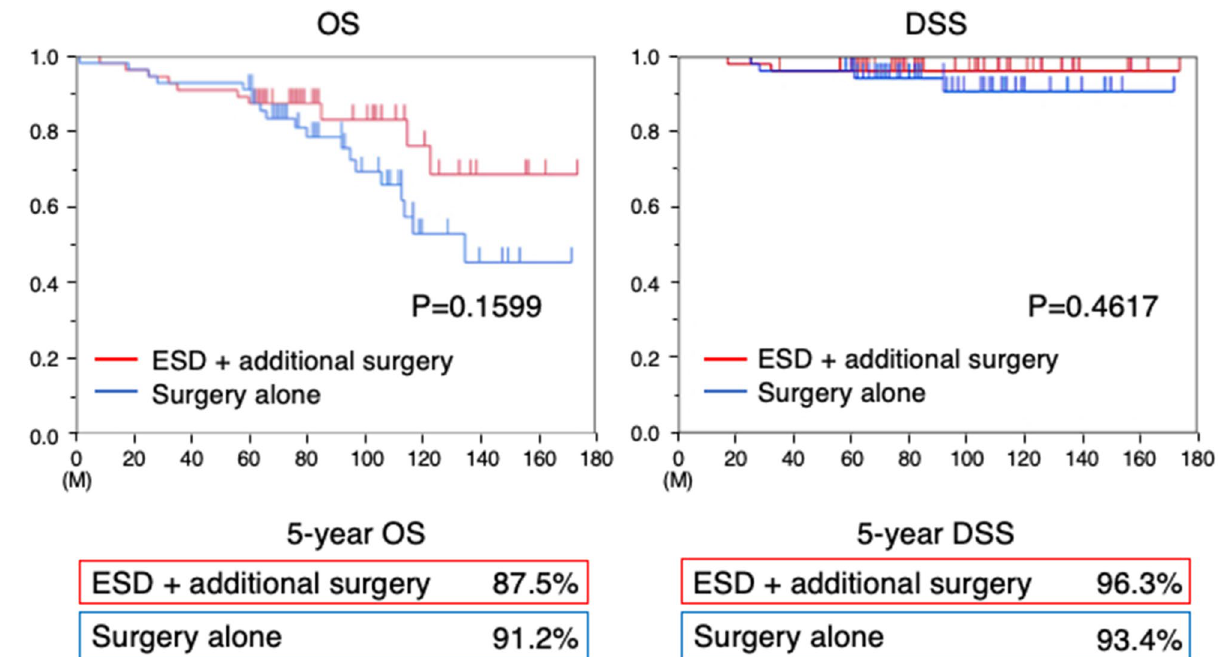
Figure. 3. This figure showed Kaplan–Meier curves for the prognosis of the two groups. After propensity score- matching, there were no significant differences in 5-year OS rates and 5-year DSS rates after treatment of gastric cancer with submucosal deep invasion between two groups. OS; overall survival rate, DSS; disease specific survival